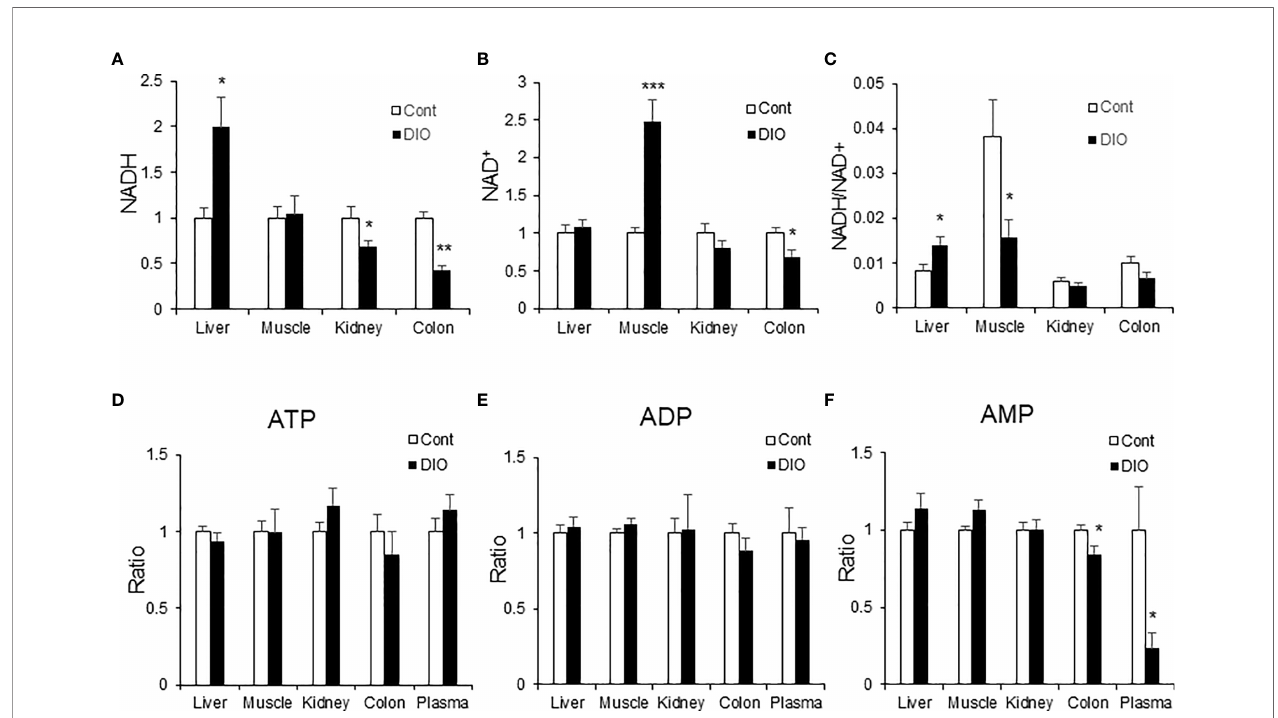
FIGURE 7 | NADH was elevated in the liver of DIO mice. The energy-related metabolites were quanti fi ed by the targeted metabolomics in multiple tissues (liver, muscle, kidney, colon and plasma) of DIO mice at 16 wk on HFD. The control mice were on chow diet. The relative abundance of NADH, NAD+, ATP, ADP and AMP are presented in the bar fi gures. (A) NADH; (B) NAD+; (C) Ratio of NADH/NAD+; (D) ATP; (E) ADP; (F) AMP. The data represents mean ± SEM (n=6). *p < 0.05; **p < 0.01; ***p < 0.001 vs. the control